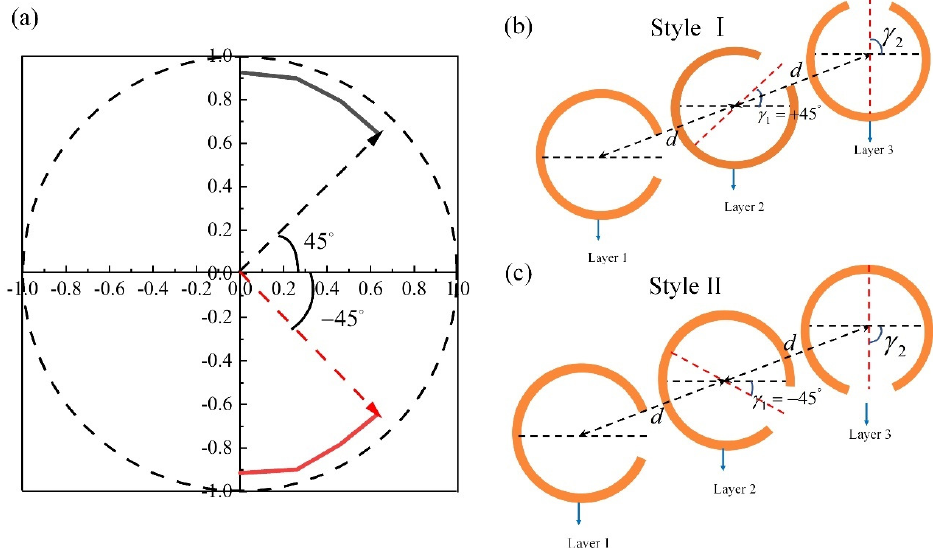
γ γ varying varying